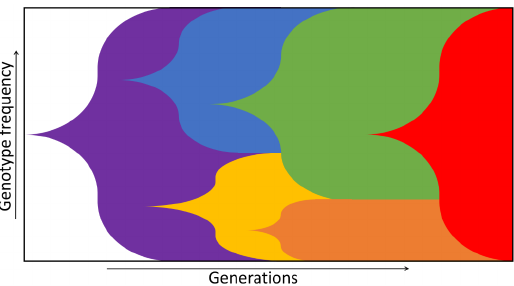
Figure 1. A Muller plot depicting the succession of different genotypes (colours). New genotypes arise that can fill certain niches (blue, yellow) or take over the whole population by outcompeting others (red). This leads to a new composition of the population in a specific environment. Adapted from Barrick et al.